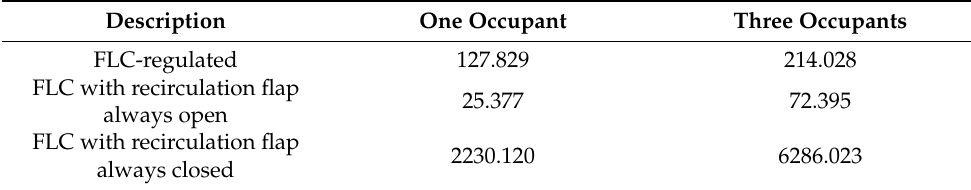
Table 7. Mean Average Error for CO 2 (ppm) in simulations with different setups.